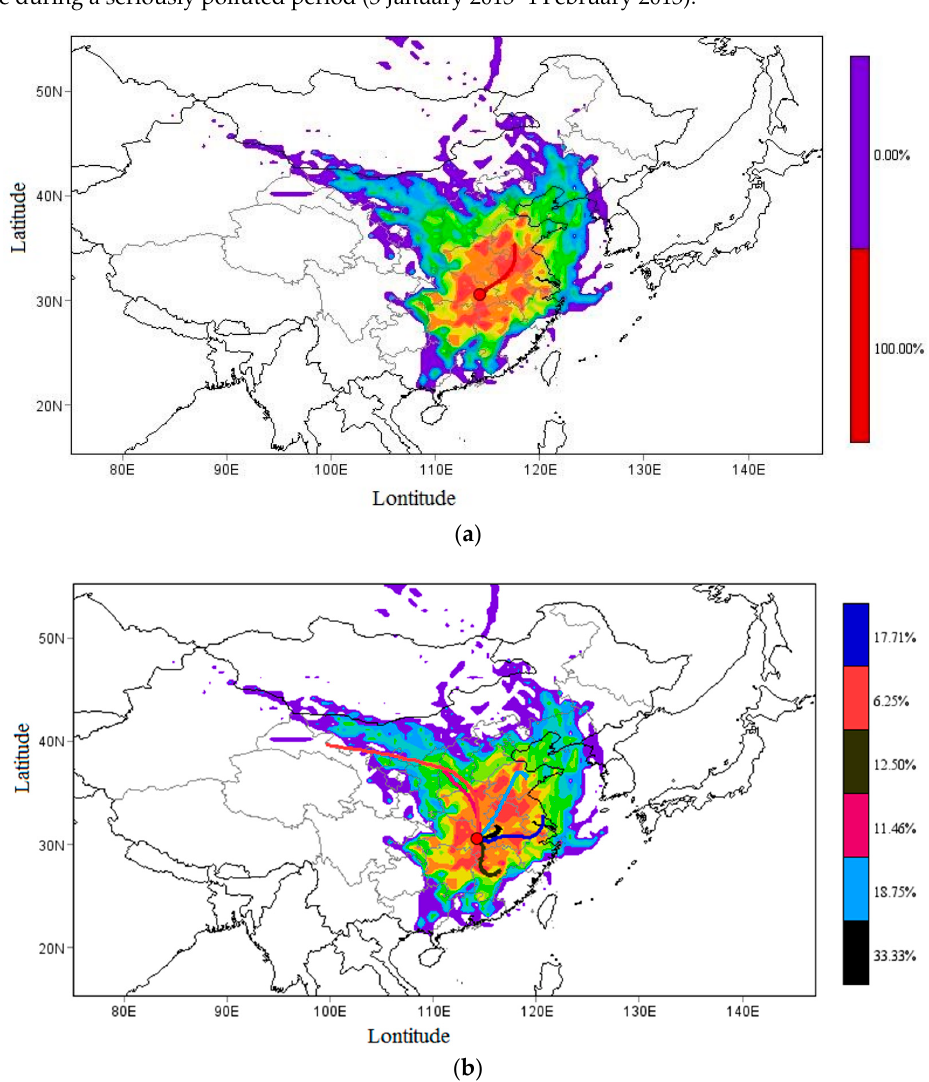
Figure 9. WPSCF map showing Cluster-mean trajectory result for ( a ) first stage (3–12 January 2013), ( b ) second stage (13 January 2013–4 February 2013) of the heavy pollution period in Wuhan (the orange